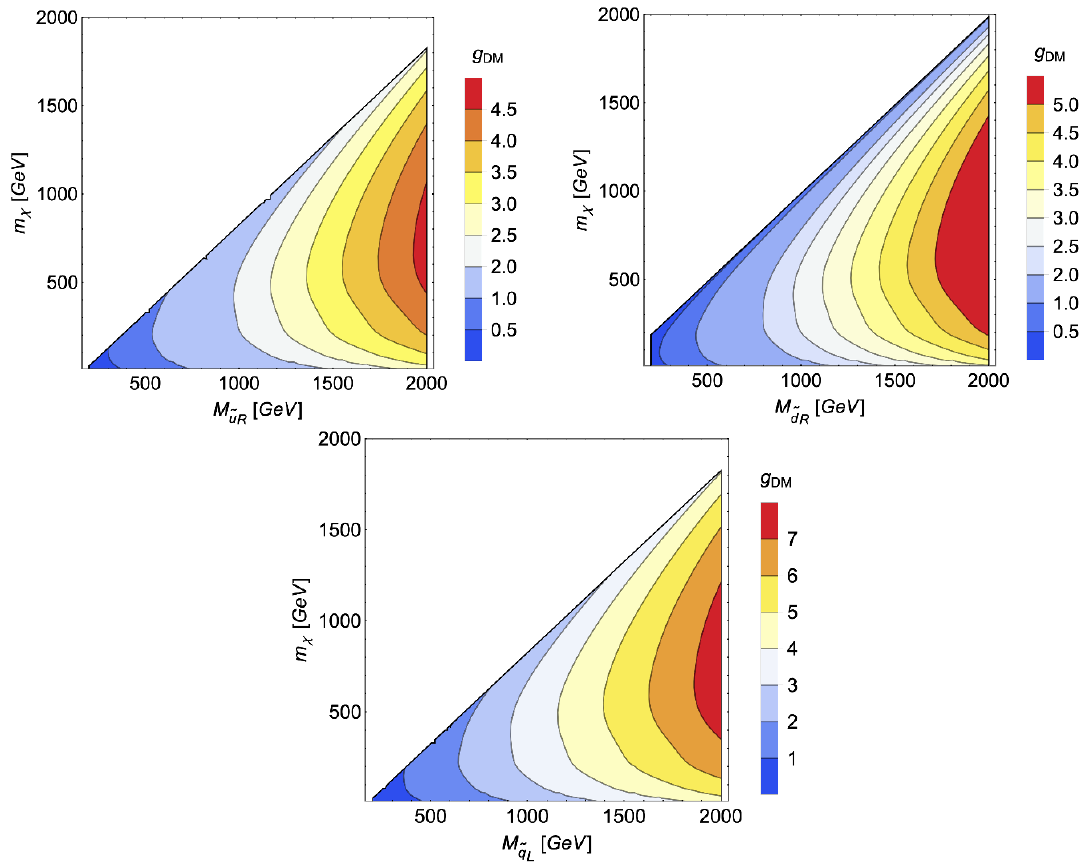
Figure 5 . Limits on g DM in the plane of the dark matter and mediator masses from the SD cross section for the u R (upper left), d R (upper right) and q L (bottom)